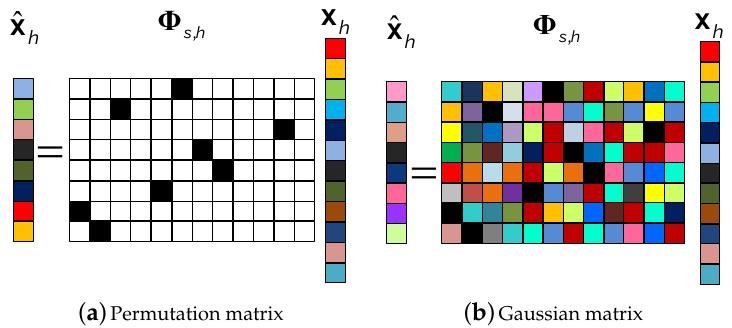
Figure 8. The active CS process at each array sensor using a projection matrix constructed from a permutation or Gaussian